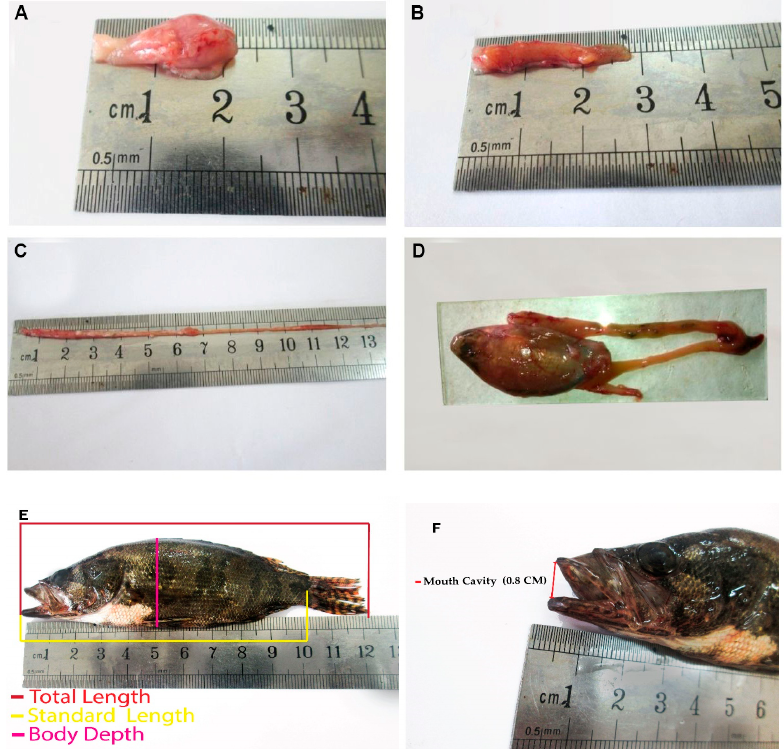
Figure 2. Photographs showing different parts of morphometry and the gastrointestinal tract: ( A ) esophagus, ( B ) tapering stomach, ( C ) tubular intestine, ( D ) engulfed fish in stomach, ( E ) morphometry, and ( F ) mouth cavity.